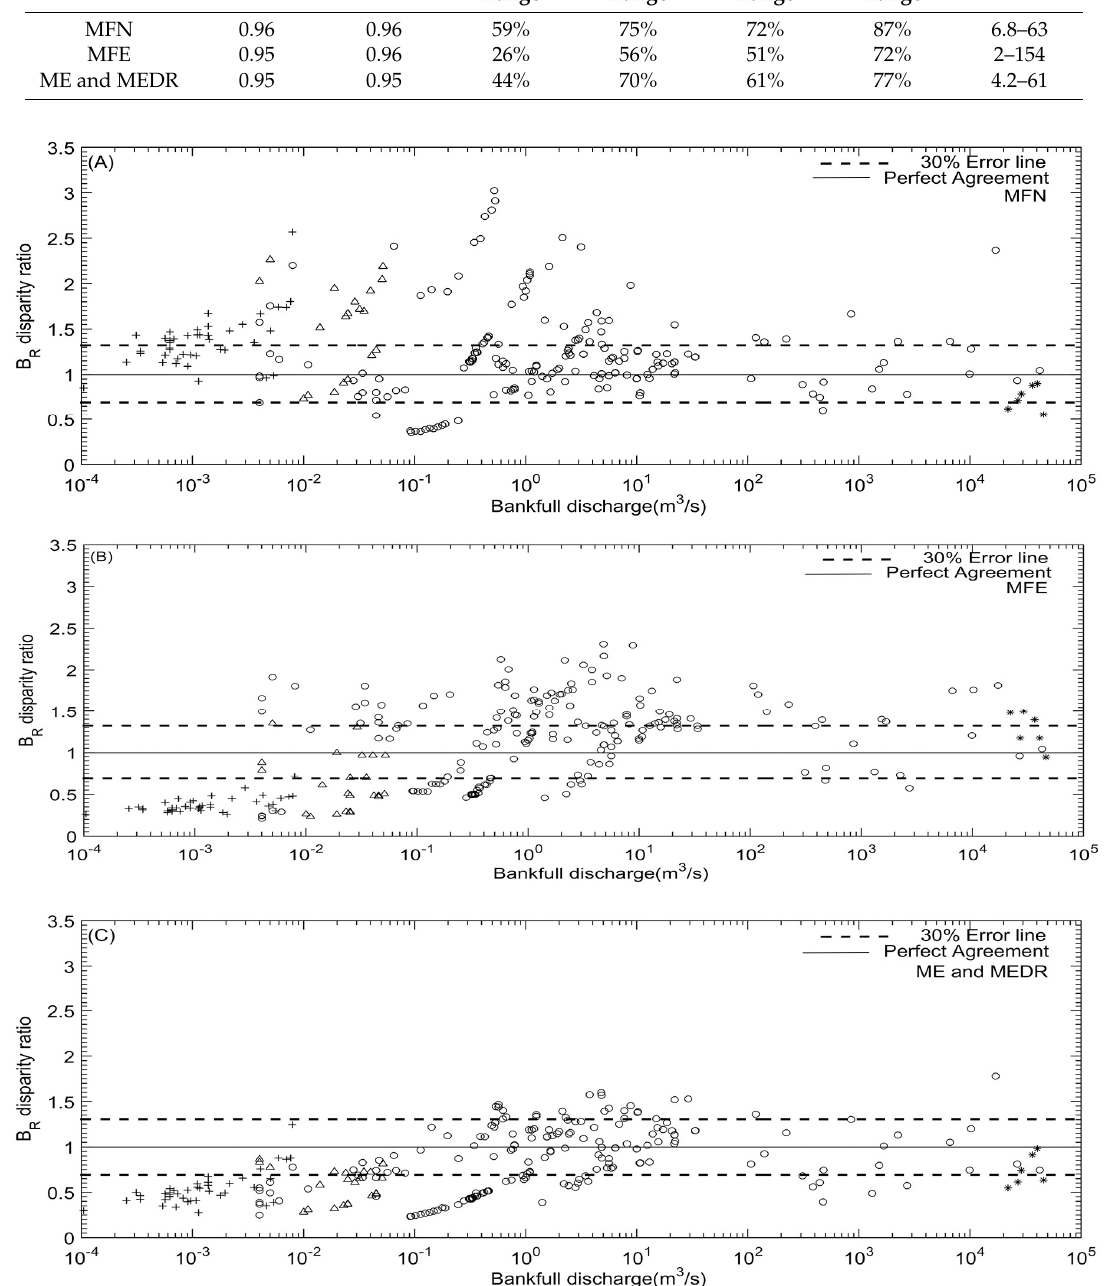
Figure 3. Scatter plot of disparity ratio B R against bankfull discharge for sand bed channels [27,45–47]. ( A ) MFN; ( B ) MFE; ( C ) ME and MEDR. Same legend as on Figure 1 applies here.